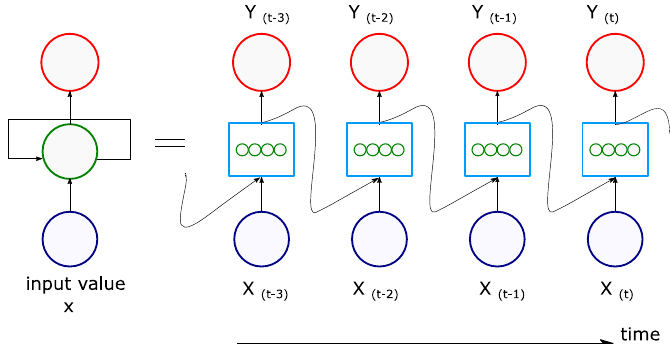
Figure 3. Example of a simple Recurrent Neural Network (RNN) architecture.